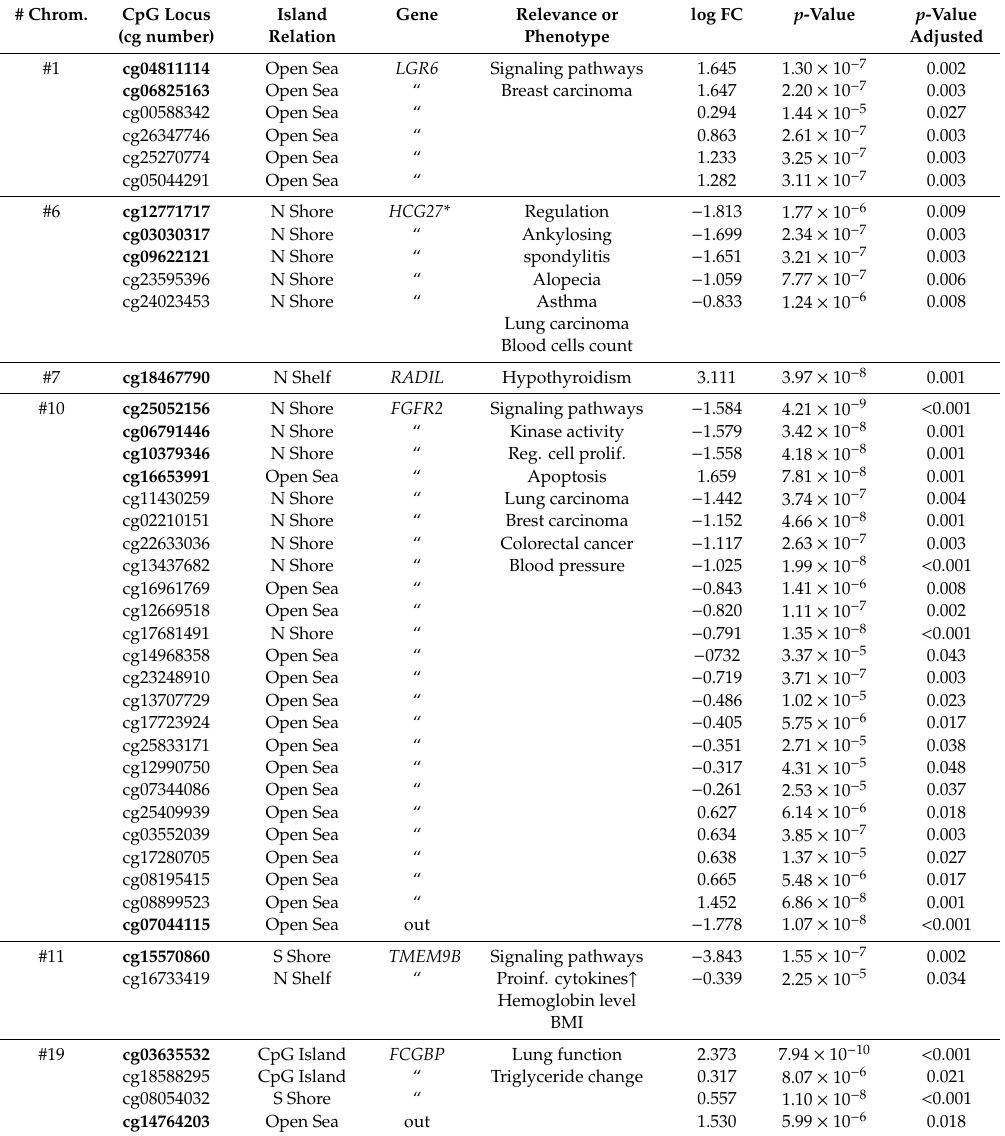
Table 2. Overview of information related to the 14 most di ff erentially methylated CpG loci (bold) in the exposed group when compared to the controls including all other significant results in the same